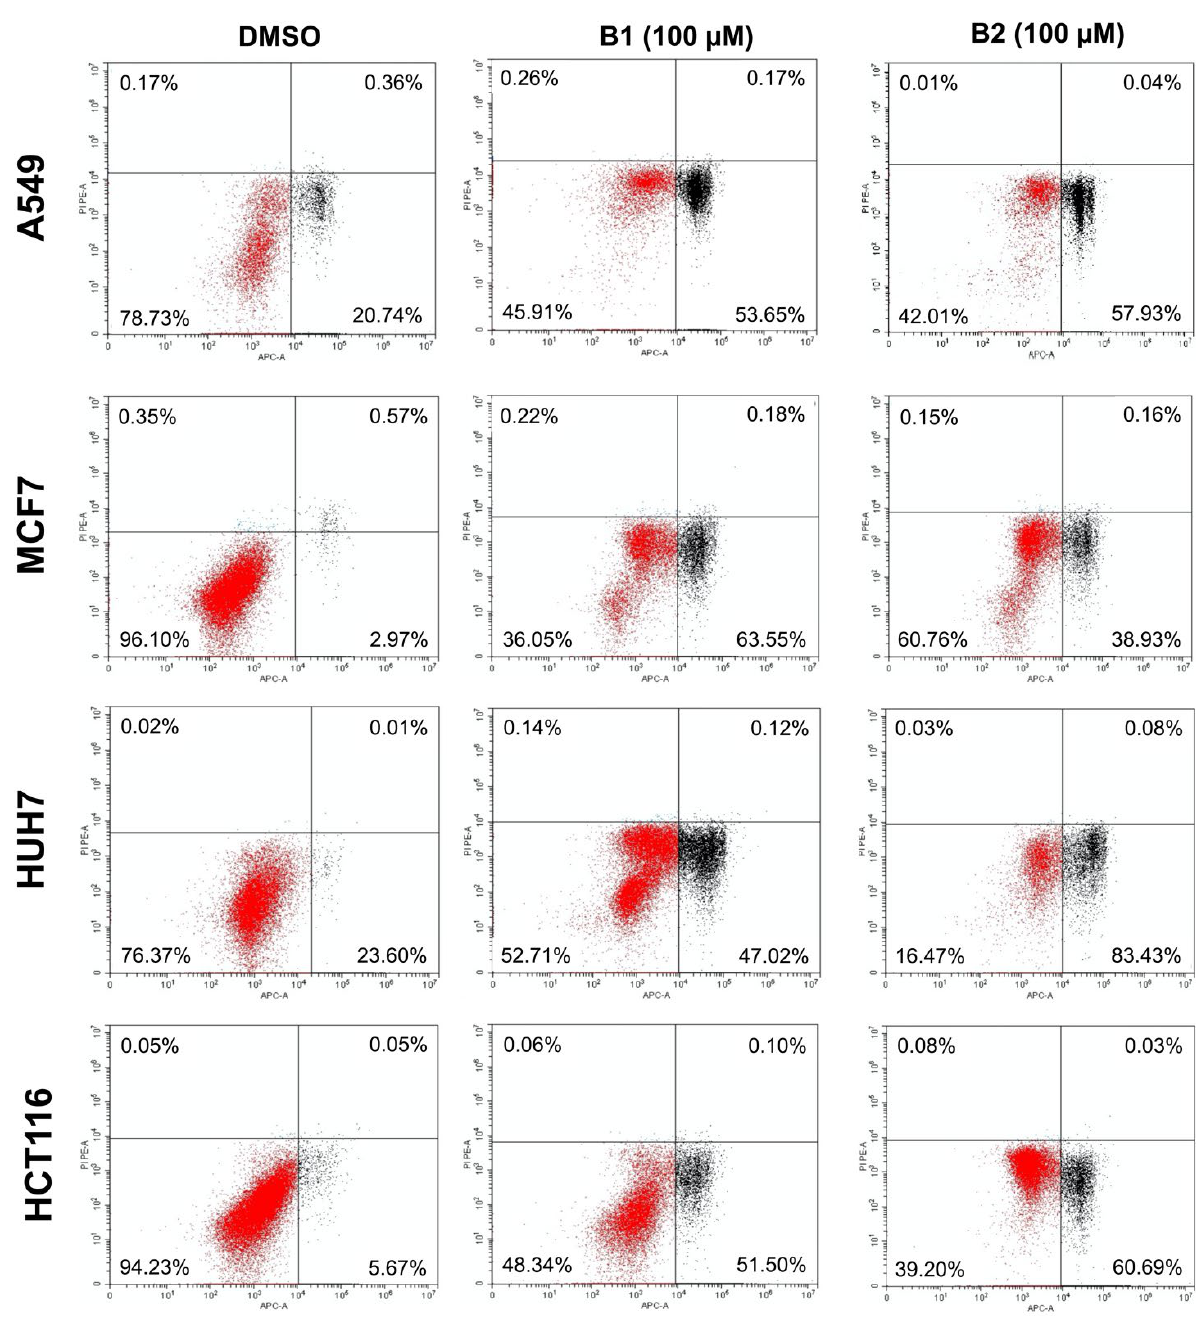
Figure 3. Apoptotic cell rates in the A549, MCF7, HUH7, and HCT116 cells treated with B1 , B2, and equal amount of DMSO as a control. Apoptosis ratio was measured by flow cytometry. The upper (late) and lower (early) right quadrants show the apoptotic cell population.